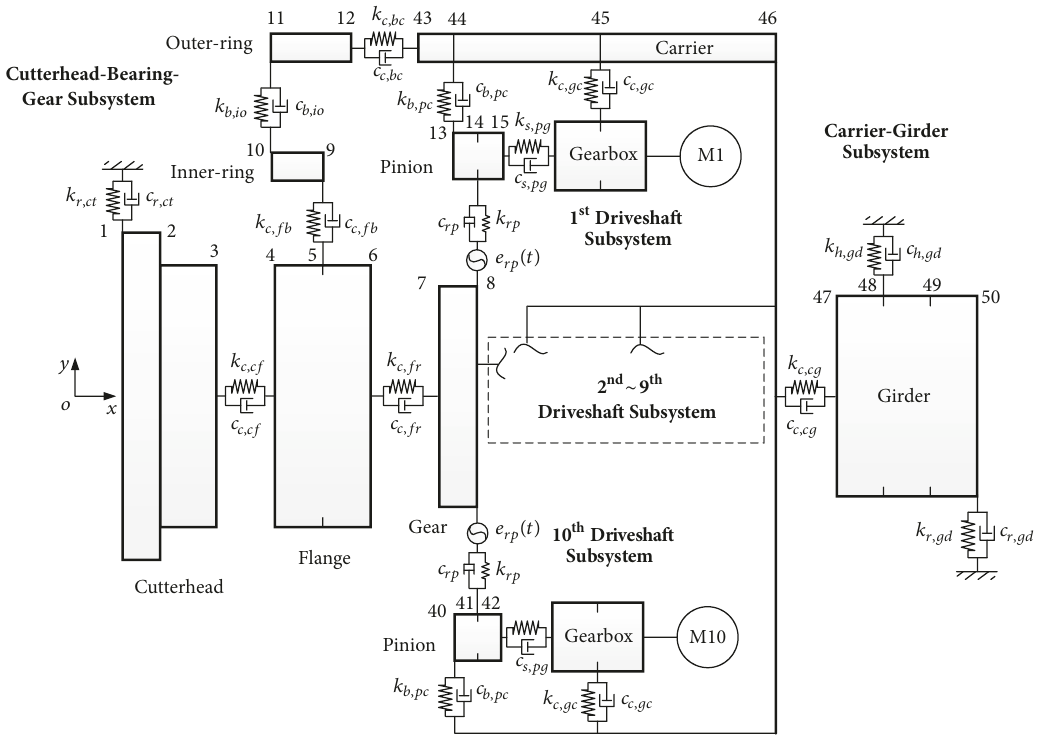
Figure 2: Hierarchical dynamics model of TBM cutterhead driving system.